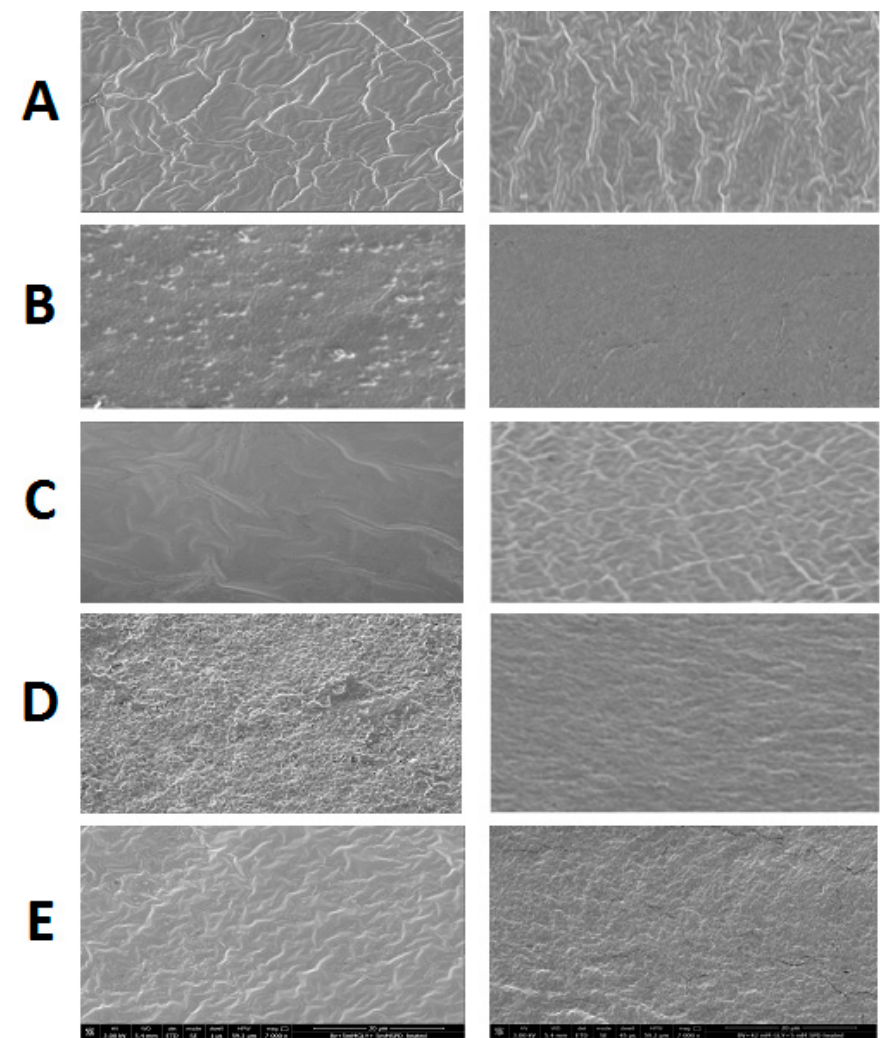
Figure 3. SEM micrographs at 7000 × magnification of the film surfaces (left) and cross sections (right) obtained from native ( A – C ) and heat-denatured ( D , E ) BVPC in the presence of 5 mM SPD with ( C , E ) or without ( B , D ) 42 mM GLY, as well as in the absence of both SPD and GLY ( A ). The sample prepared with heat-denatured BVPC in the absence of SPD was not analyzed because not handleable for its stickiness. The images shown were chosen as the most representative of each sample. Further experimental details are given in the text.